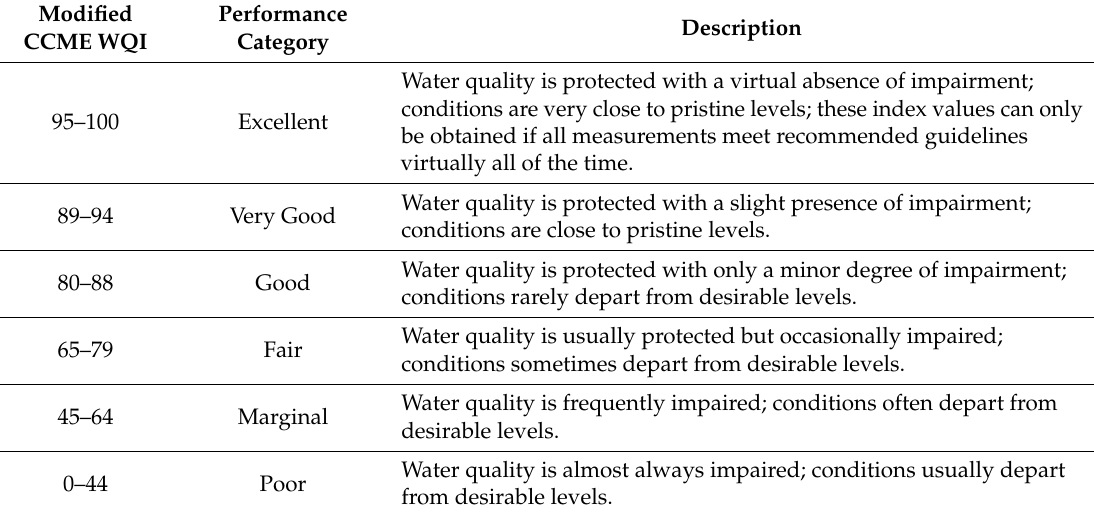
Table 2. Categorization of the modified CCME WQI as defined by CCME (CCME [2]).